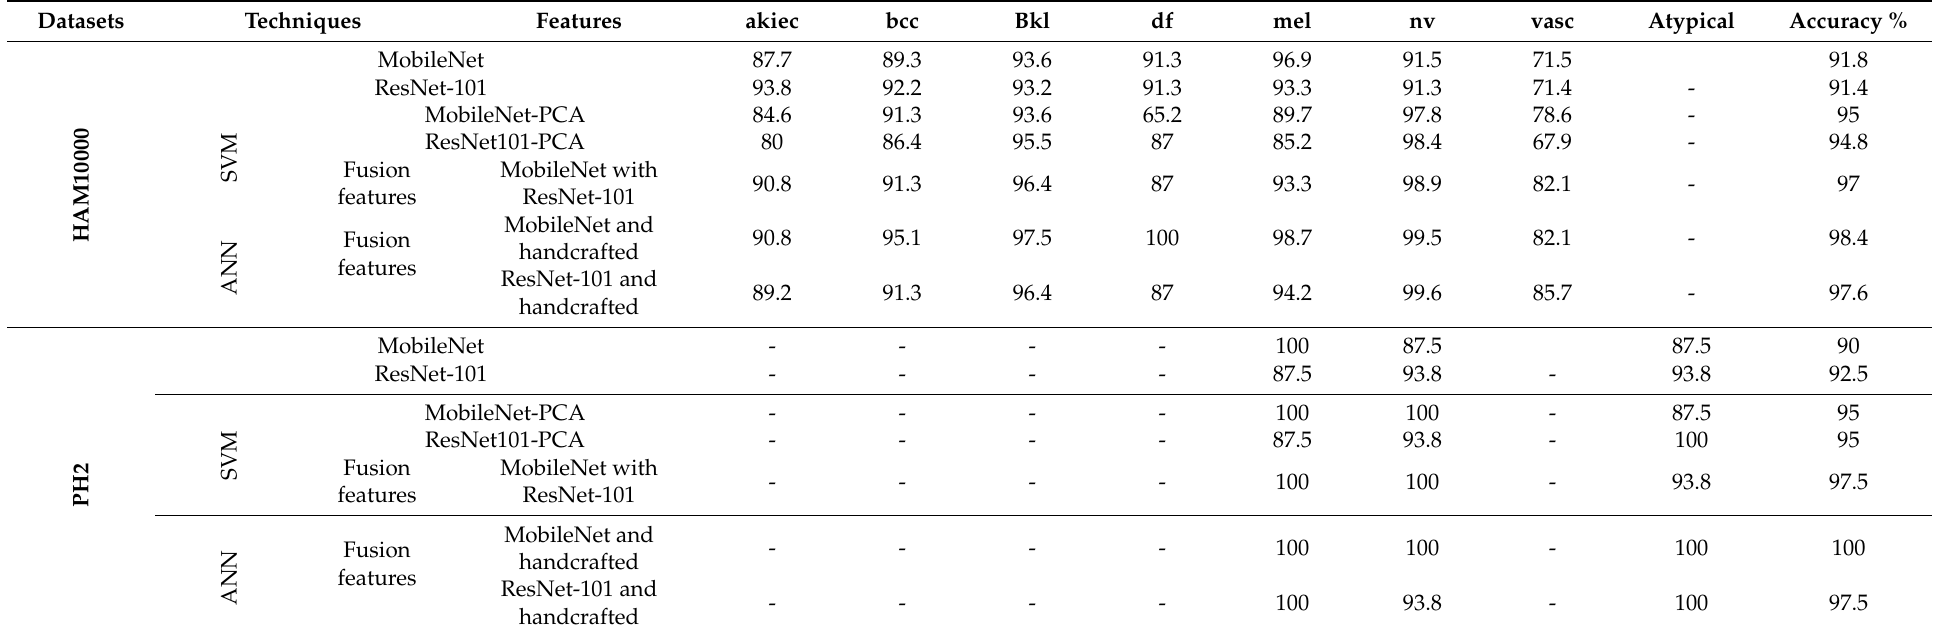
Table 11. Results of systems classification for the two datasets for skin lesions, HAM10000 and